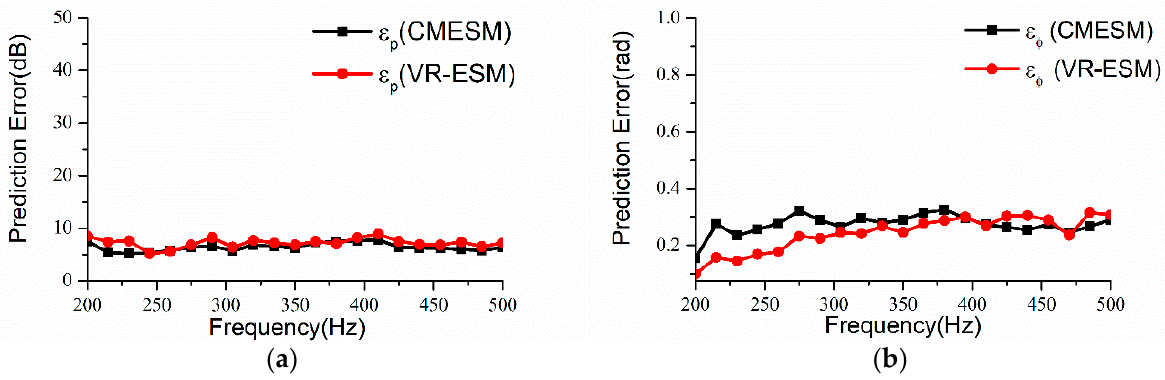
Figure 17. Prediction errors of sound pressure and phase at different frequencies ( ℎ (cid:3022) = 0.2 m ). ( a ) 𝜀 (cid:3043) and ( b ) 𝜀 Ф .